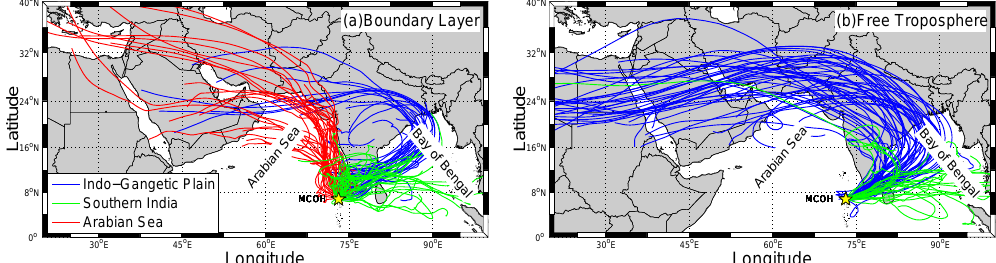
Figure 2. Seven-day-backward trajectories calculated by the HYSPLIT model arriving in the MBL at 400m (a) and in the FT 2000m (b) above MCOH at 00:00 and 12:00UTC each day during CARDEX in February and March 2012. Colours represent the air mass source regions Indo-Gangetic Plain (blue), southern India (green) and the Arabian Sea (red).